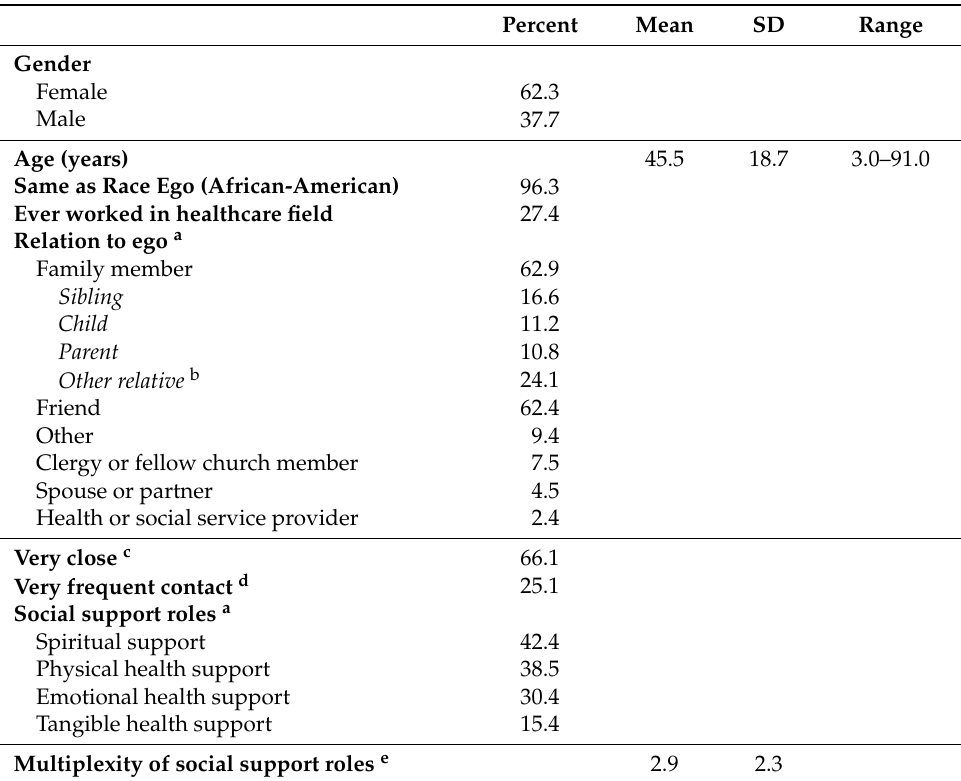
Table 2. Alter and Tie Descriptive Statistics ( n =